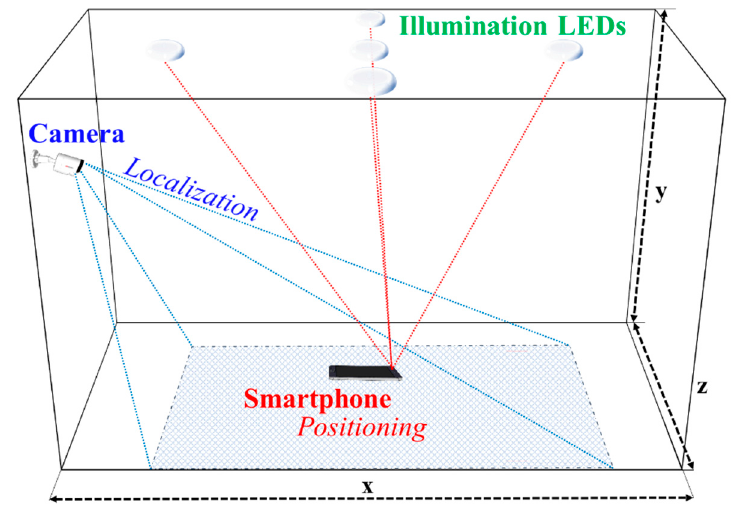
Figure 31. Indoor positioning schemes for OCC.